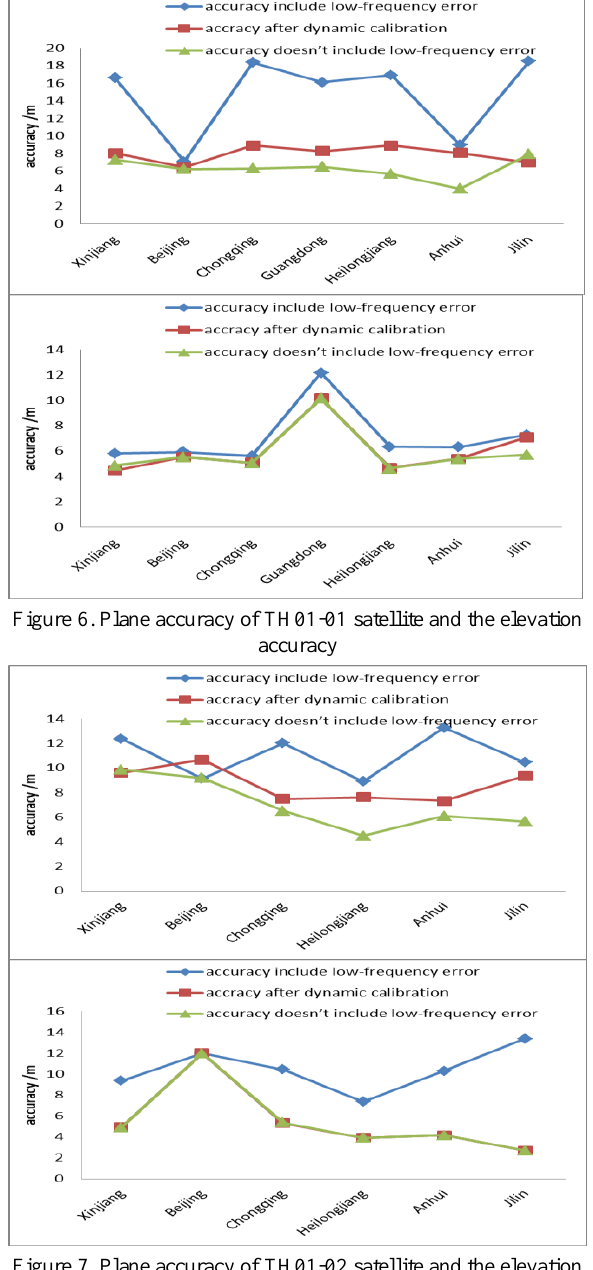
Table 9. Positioning accuracy without ground control points